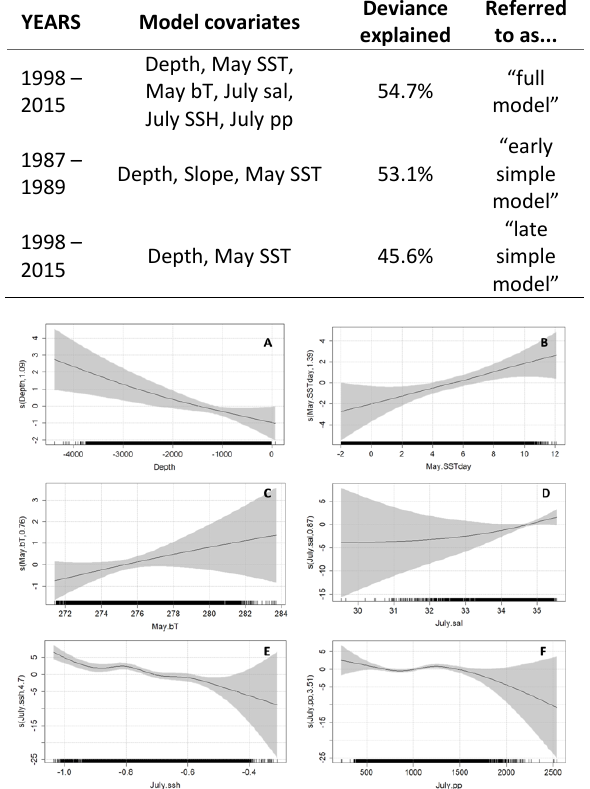
Figure 3. Smooth plots of the covariates included in the best-fitting full model, where covariates are averaged over 1998-2015. Positive values of the smooth functions (vertical axis) indicate a positive effect on sei whale relative density. Tick marks on the horizontal axis show the distribution of the data. Vertical axis scales vary among plots. Black lines show the lines of best fit, grey shaded areas represent 95% confidence intervals. Panel A: Water depth [m] (effective degrees of freedom (edf) = 1.09, p = 0.00044). Panel B: May SST [ o C] (edf = 1.39, p = 0.00066). Panel C: May bottom temperature [K] (edf = 0.76, p = 0.033). Panel D: July salinity [PSU] (edf = 0.87, p = 0.027). Panel E: July SSH [m] (edf